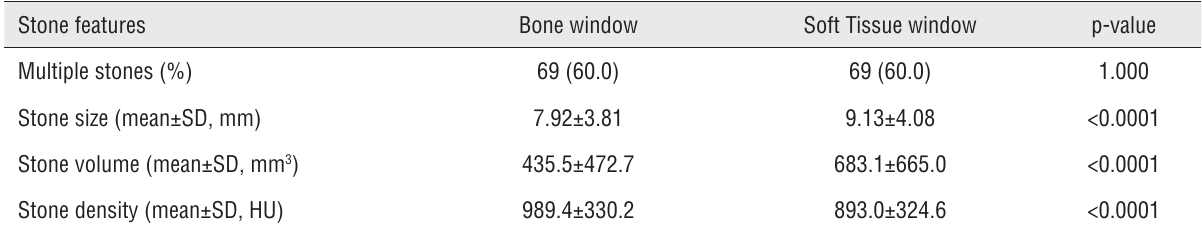
Table 1 - Comparison between pre-operative NCCT bone and soft tissue windows of the stone features of the115 renal units submitted to